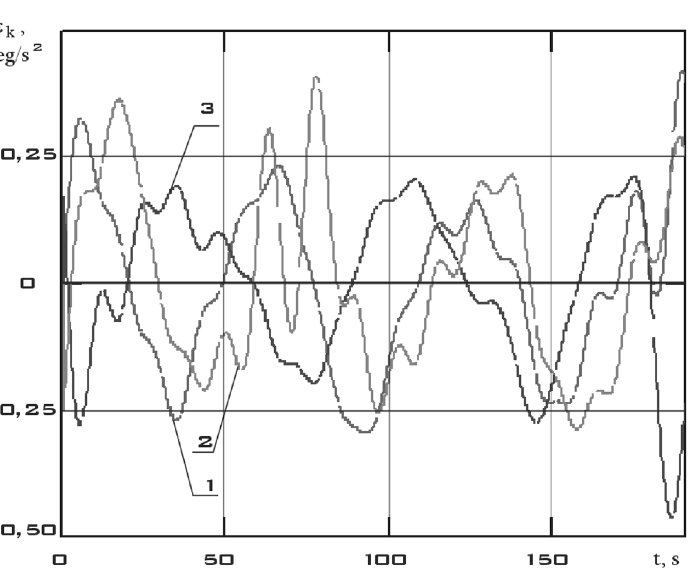
Figure 13. There are components of the angular acceleration vector in the CXYZ coordinate system 01/14/2014 from 04:41:15 to 04:44:21 (1 is ε x ; 2 is ε y ; 3 is ε z